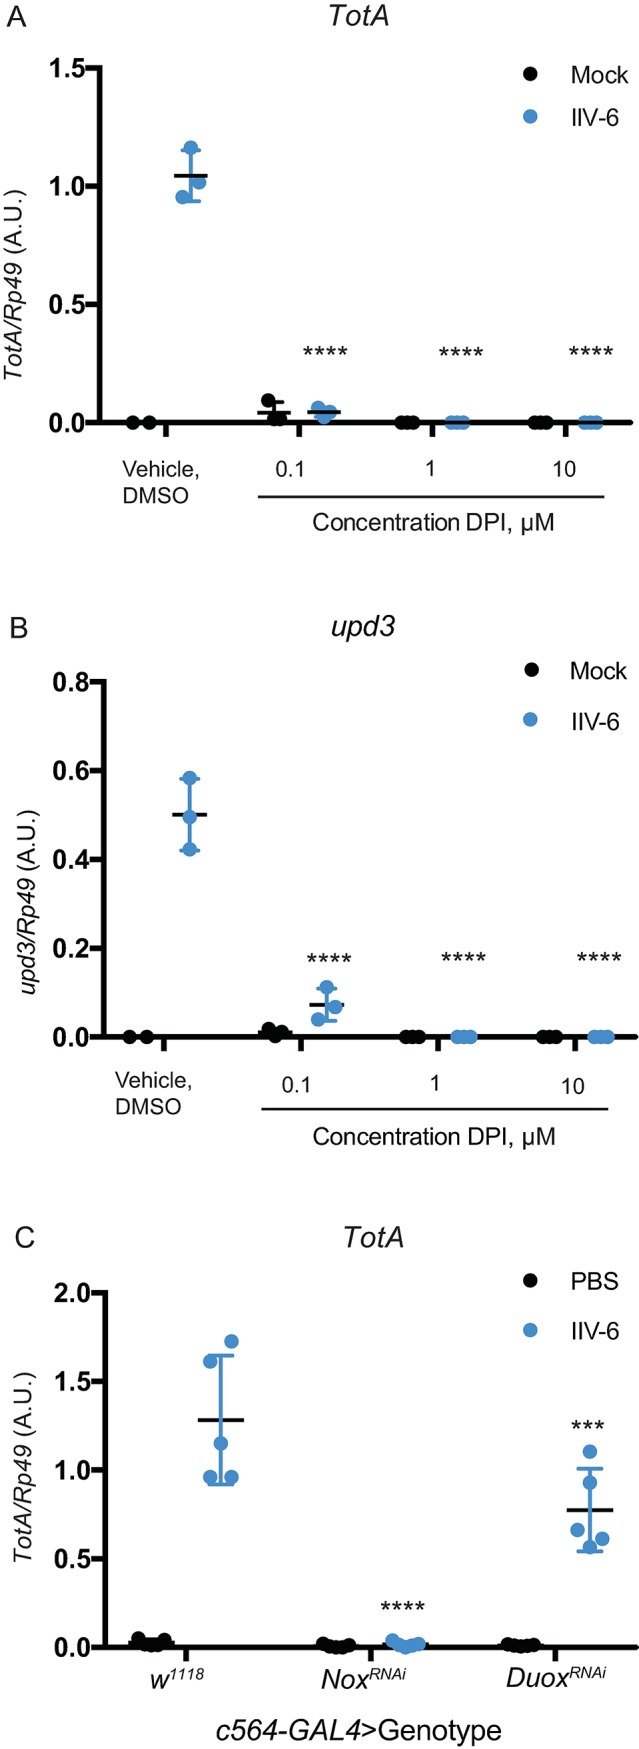
Nox is required for IIV-6 induced upd3 and turandot expression S2* cells were treated with the indicated concentrations of DPI (an NADPH oxidase inhibitor) or vehicle control (DMSO) for one hour, and then infected with IIV-6 or mock treated. A)
TotA expression and B)
unpaired3 expression were quantified by qRT-PCR 24 hours post-infection. For A) and B), 3 biologically independent replicates are shown, and statistics performed comparing virus infected vehicle treated to DPI treated conditions. C)
UAS-NoxRNAi and UAS-DuoxRNAi flies were crossed to c564-GAL4 for fat body specific knock-down, while the control was generated by w1118 crossed to c564-GAL4. Progeny were infected with IIV-6 or injected with PBS, and TotA expression was measured in whole flies by qRT-PCR 24 hours post-infection. 5 biologically independent replicates are shown. For all panels, error bars represent standard deviation, black lines indicate the mean, and statistical significance was determined using two-way ANOVA with Sidak’s correction.(***p = 0.0004, ****p<0.0001). A.U., Arbitrary Units.